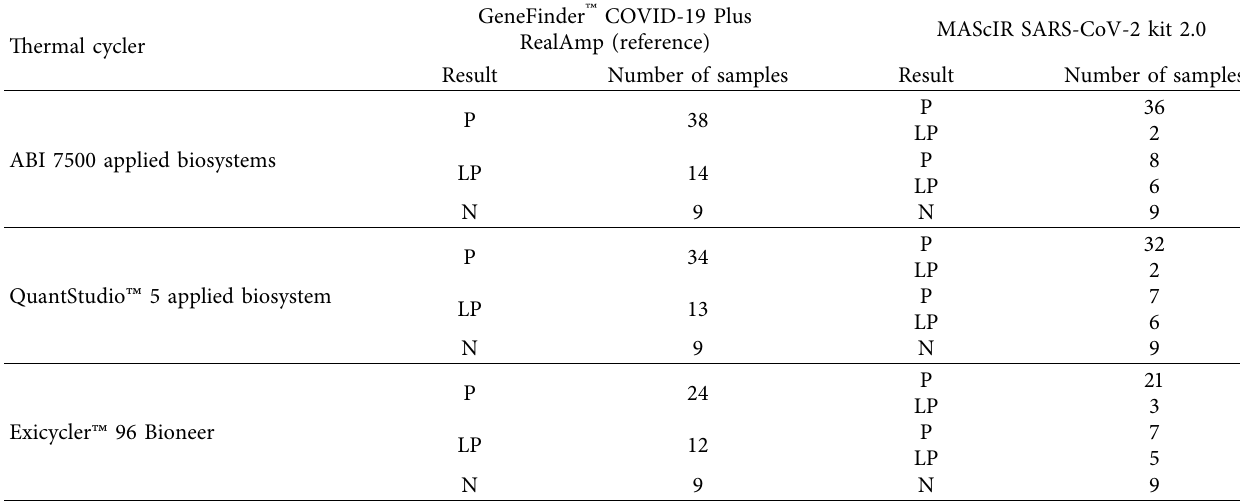
Table 4: Analysis of qualitative results.